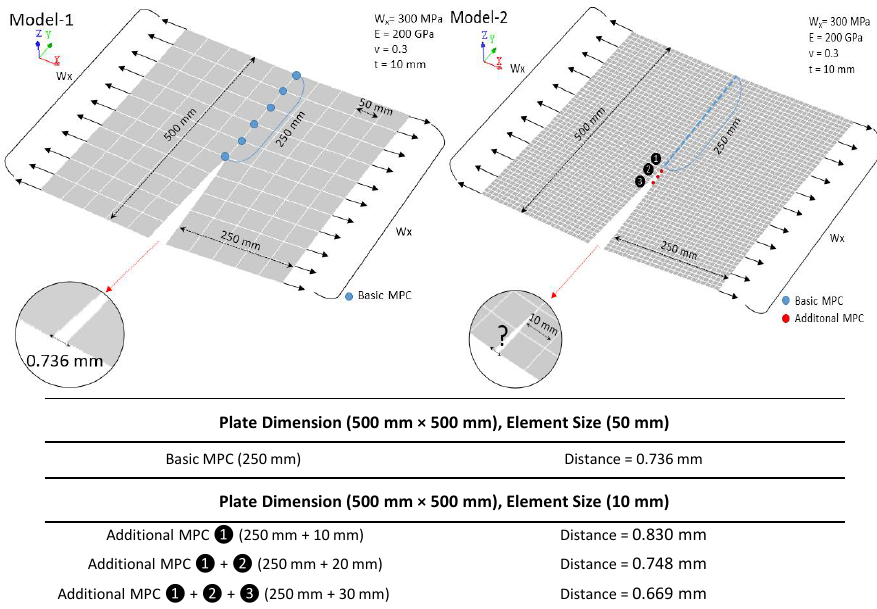
Figure 5. MPC physical explanation (Attaching two plane plate, 500 mm × 250 mm).